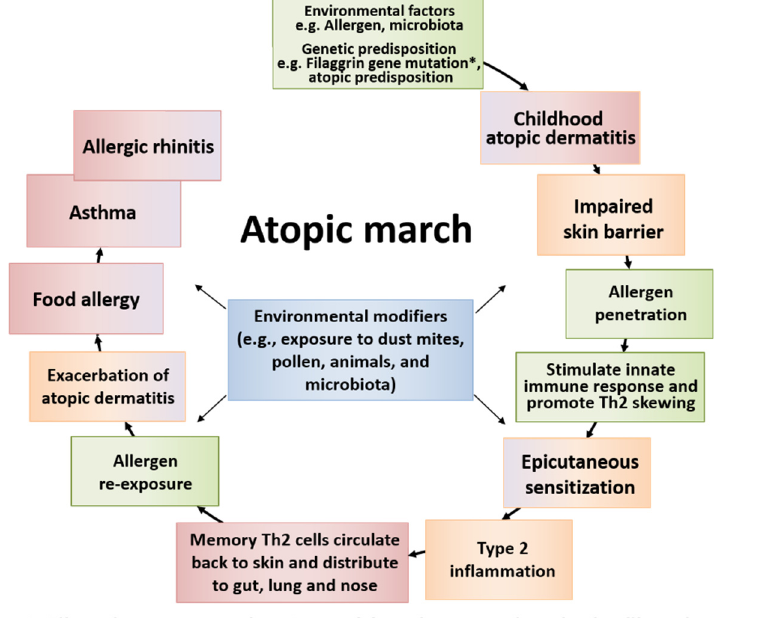
Figure 2. The general course of atopic march and the temporal sequence of major factors involved. Atopic march is the clinical history of atopic diseases in different organs, wherein different causal allergens develop sequentially with age. Some symptoms become more prominent over time, while others subside. Atopic dermatitis (AD) generally develops first based on genetic predisposition and/or environmental factors. The skin barrier dysfunction derived from AD easily allows the aller- gen to penetrate the body, causing epicutaneous sensitization and type 2 inflammation in some chil- dren. Then, memory T helper 2 (Th2) cells circulate back to the skin and exacerbate AD. The cells then distribute to the gut, lung, and nose. Patients develop food allergy, allergic asthma, and allergic rhinitis with increased sensitization to food and/or environmental allergens, resulting in the induc- tion of atopic march.